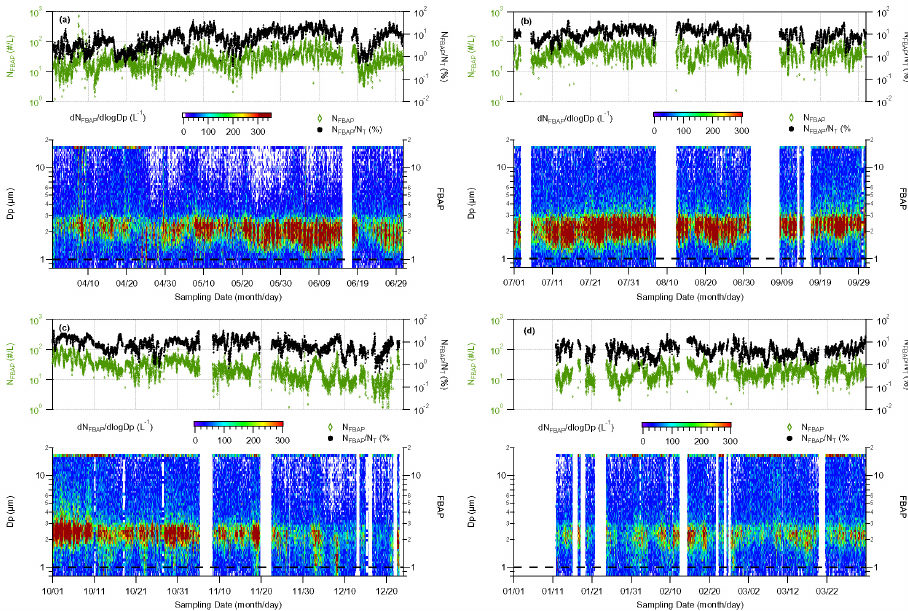
Fig. 7. WIBS-4 fluorescence data for one year online measurement term (April 2010–March 2011). The data are plotted in the same way as in Fig. 3. The color scale in the lower image plots represents d N FBAP /dlog D p . (a) spring, (b) summer, (c) autumn, and (d) winter period.